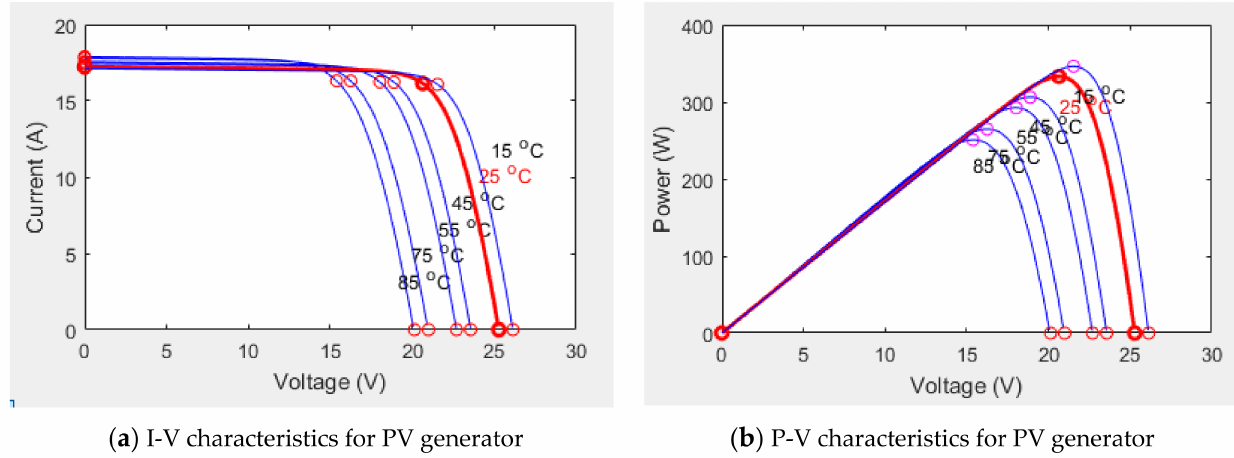
Figure 5. I-V (current—voltage) and P-V (power—voltage) characteristics for the analyzed PV generator for different values of